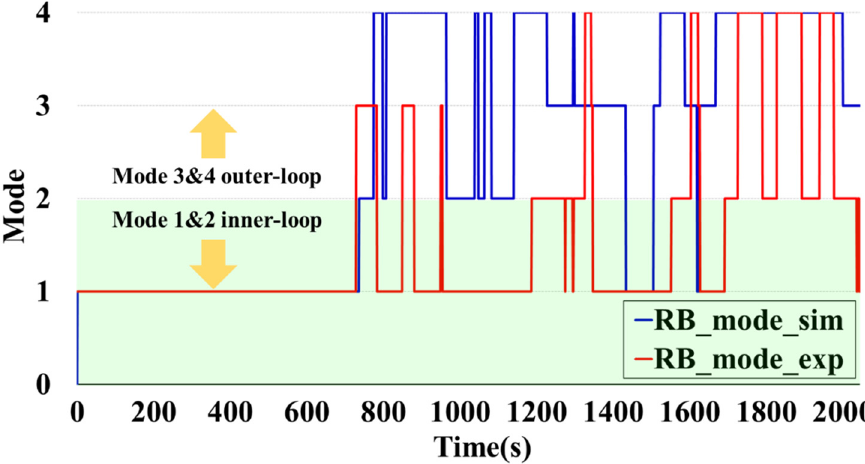
Figure 10. Simulation/experiment comparison of the mode-switch timing.